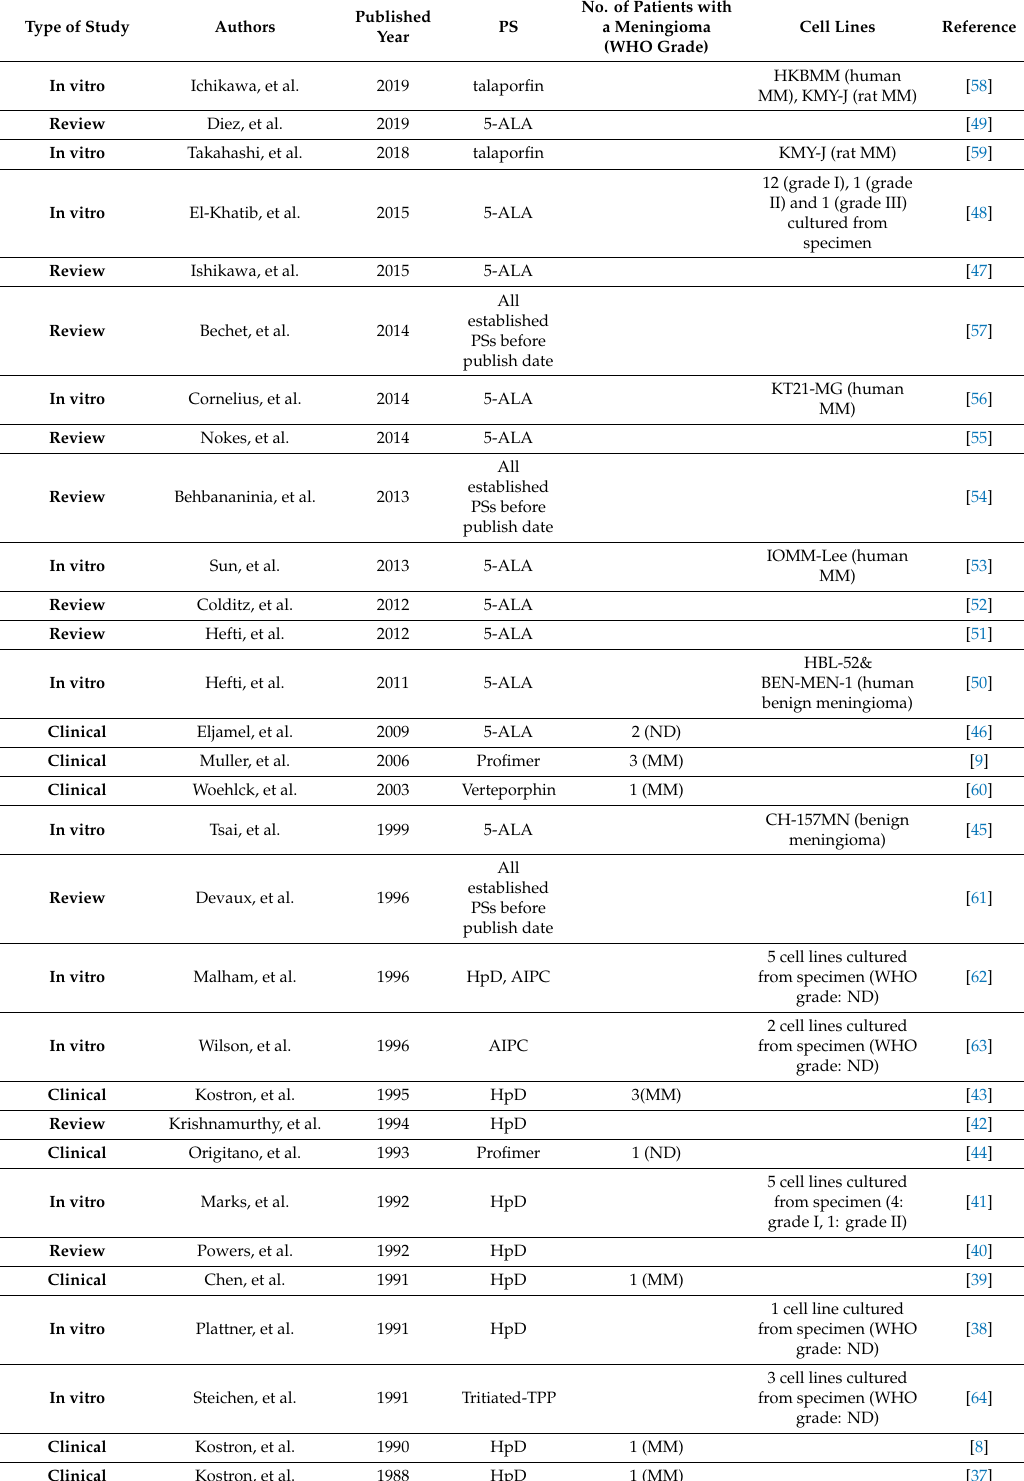
Table 3. PDT studies for